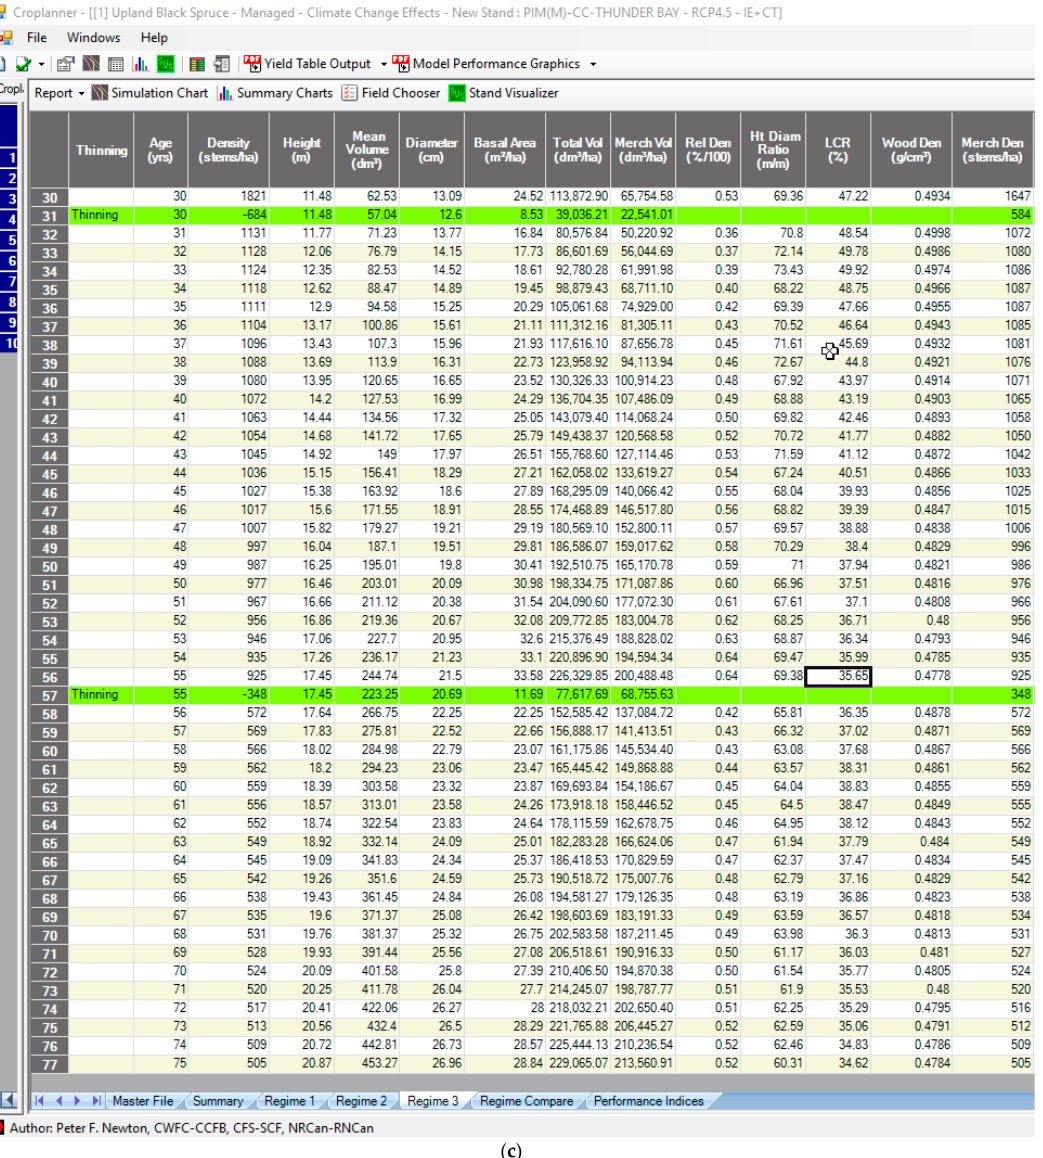
Figure 4. Exemplifying the iterative crop plan selection ability of the CP DSS ; specifically within the context of comparing two CT-based regimes and an unthinned control regime for managed stand-types (black spruce plantations) while simultaneously accounting for localized climate change effects: ( a ) input GUI dialog with end-user required input consisting of the (i) simulation identifier (name), site index, operability criteria, economic parameters, and model defaults (merchantability specifications), (ii) regime-specific (crop plan) specifics in terms of initial density, expected ingress, rotation age, genetic worth, selection age and response model type, operational adjustment and product degrade factors, variable cost estimate at harvest, and climatic change scenario inclusive of locale-specific temperature and precipitation values by commitment period (n., values can be either auto-populated for representative locales and climate change scenarios or manually inputted by the end-user), and (iii) thinning treatment specifics for Regimes 2 and 3 (age and type of each thinning, removal units and thinning intensity, and fixed and variable thinning cost estimates); ( b ) resultant crop plans presented within traditional SDMD graphic, tabular summaries of rotational performance metrics, and example stand visualization graphic at rotation (Regime 3); and ( c ) example regime-specific (Regime 3) annual tabular output for selected variables inclusive of CT yield estimates. Refer to Summary Report SM3 (Supplementary Material) for a complete account of the output produced for this specific set of crop